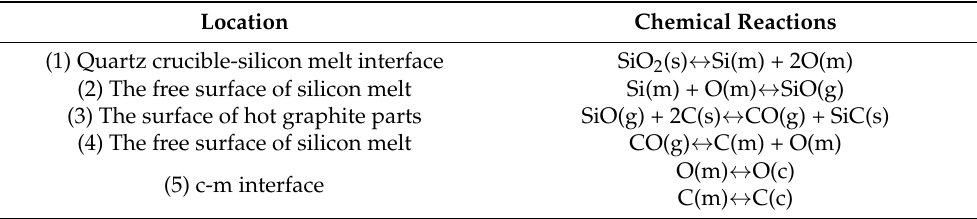
Table 1. Chemical reactions in the transport of oxygen and carbon impurities.